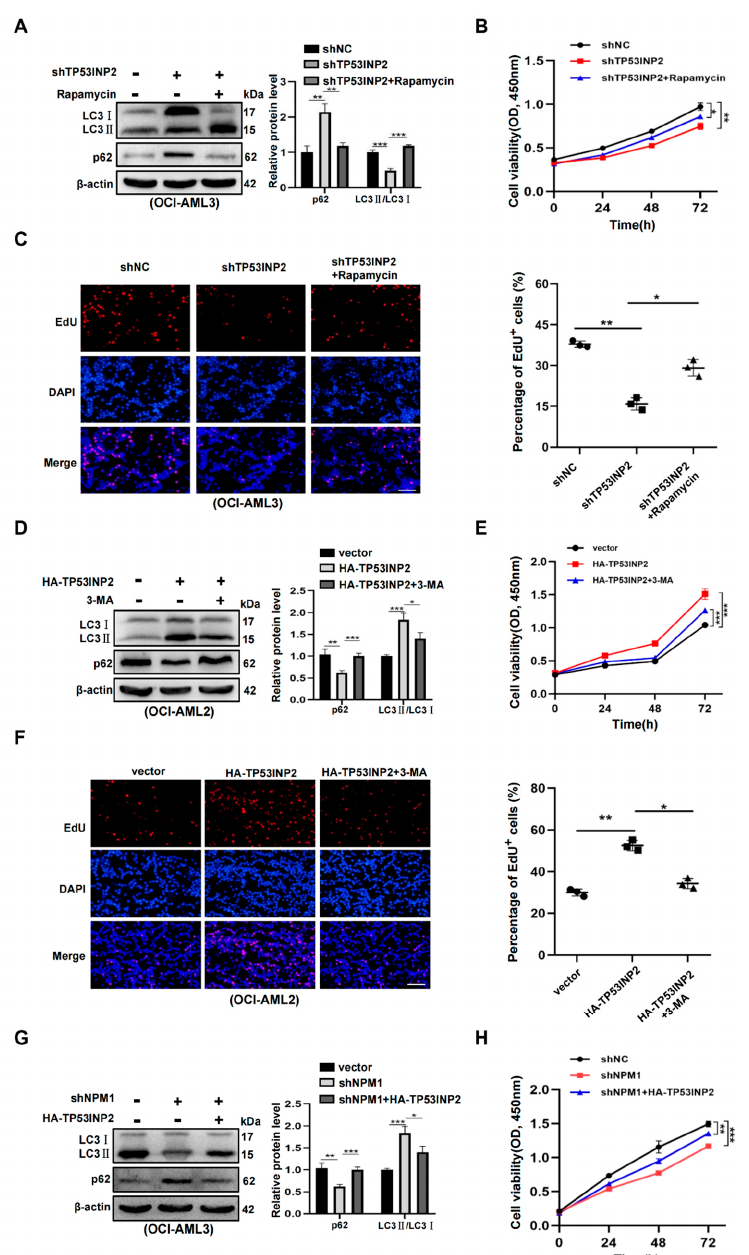
Figure 6. TP53INP2-mediated autophagy plays an essential role in leukemia cell survival. ( A , D ) Western blot analysis of LC3 II/I and p62 protein expression in TP53INP2-silenced OCI-AML3 cells treated with 5 μ M rapamycin for 10 h, and TP53INP2-enforced OCI-AML2 cells treated with 2 mM 3-MA for 10 h, respectively. The bar graph presented relative protein levels. ( B , E ) CCK-8 assay of cell growth in TP53INP2-silenced OCI-AML3 cells treated with 5 µ M rapamycin for 10 h and TP53INP2-enforced OCI-AML2 cells treated with 2 mM 3-MA for 10 h, respectively. ( C , F ) EdU analysis of cell prolifera- tion in TP53INP2-silenced OCI-AML3 cells and TP53INP2-enforced OCI-AML2 cells. The bar graph showed the percentage of EdU-positive cells. Scale bar: 100 µ m. ( G ) Western blot analysis of LC3II/I and p62 expression in the NPM1-mA-silenced OCI-AML3 cells following TP53INP2 overexpression. ( H ) CCK-8 analysis of cell growth ability in NPM1-mA-silenced OCI-AML3 cells following TP53INP2 overexpression. The data are presented as the mean ± SD of three independent experiments. * p < 0.05, ** p < 0.01, *** p <